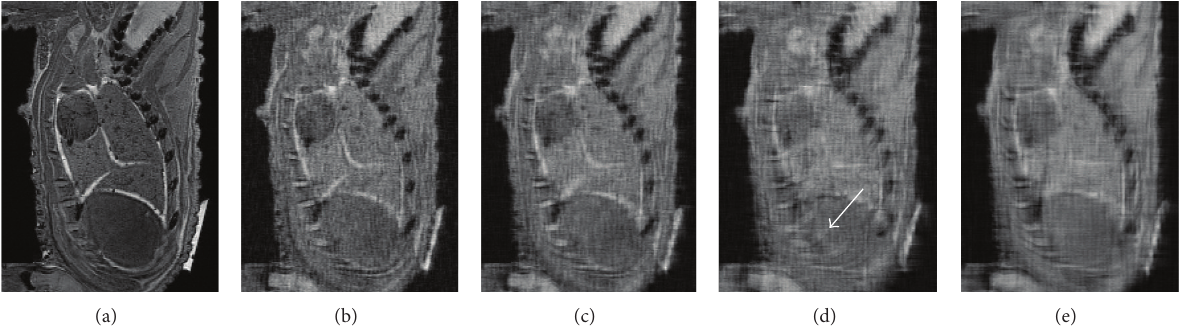
Figure 8: 2D sagittal view of the ex vivo embryo for (a) 3D isotropic acquisition and SRR images based on LR image stacks with AR equal to (b) 1:4, (c) 1:6, (d) 1:8, and (e) 1:10. White arrow highlights rib structures that are present in the SRR image but not present in the isotropic 3D image.